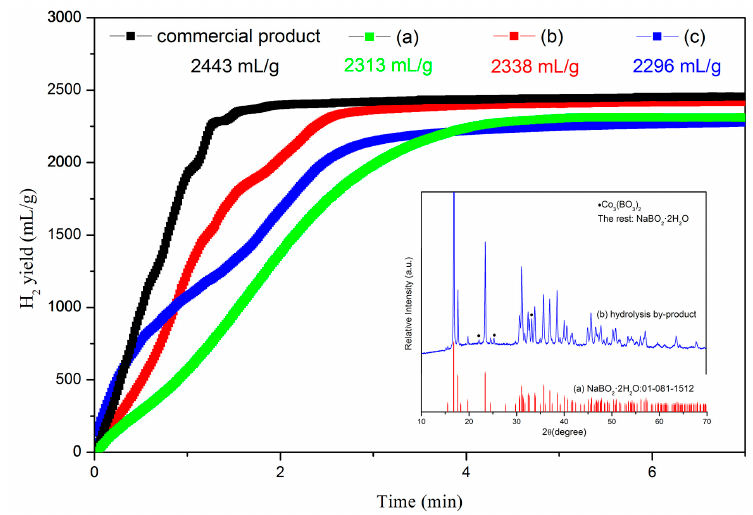
Figure 3. Hydrolysis curves of ( a ) the regeneration product (MgH 2 and NaBO 2 · x H 2 O). ( b ) The regeneration product (Mg and NaBO 2 · x H 2 O). ( c ) The purified product (Mg 2 Si and NaBO 2 · 2H 2 O) and the commercial NaBH 4 in 5 wt % CoCl 2 aqueous solution. Inset: XRD patterns of ( a ) a standard PDF card of NaBO 2 · 2H 2 O and ( b ) the hydrolysis byproduct.